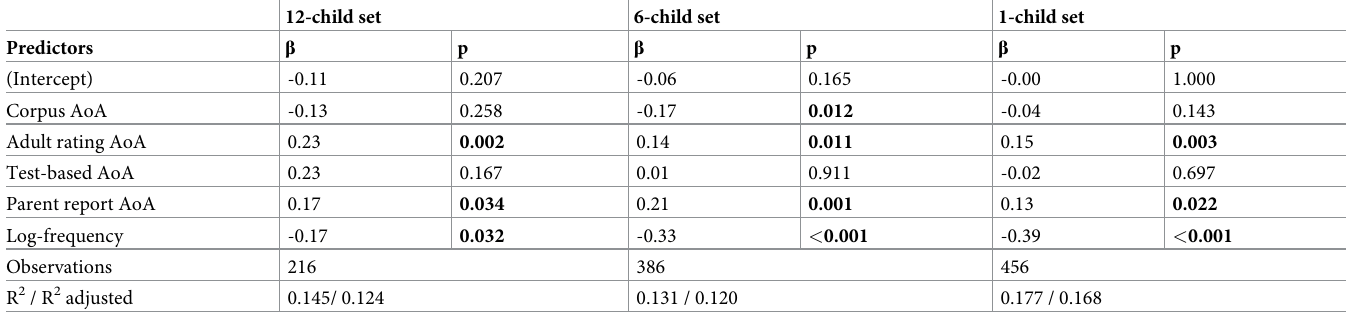
Table 4. Standardized regression estimates for models predicting lexical decision times using Corpus AoA, adult AoA ratings, and